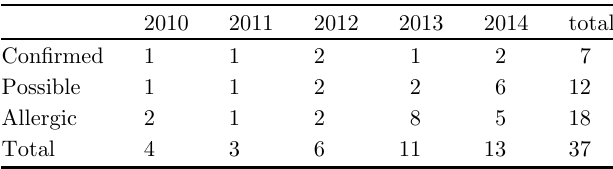
Table 1. Number of cases of anisakidosis (con fi rmed, possible or allergic) identi fi ed in France, 2010 –